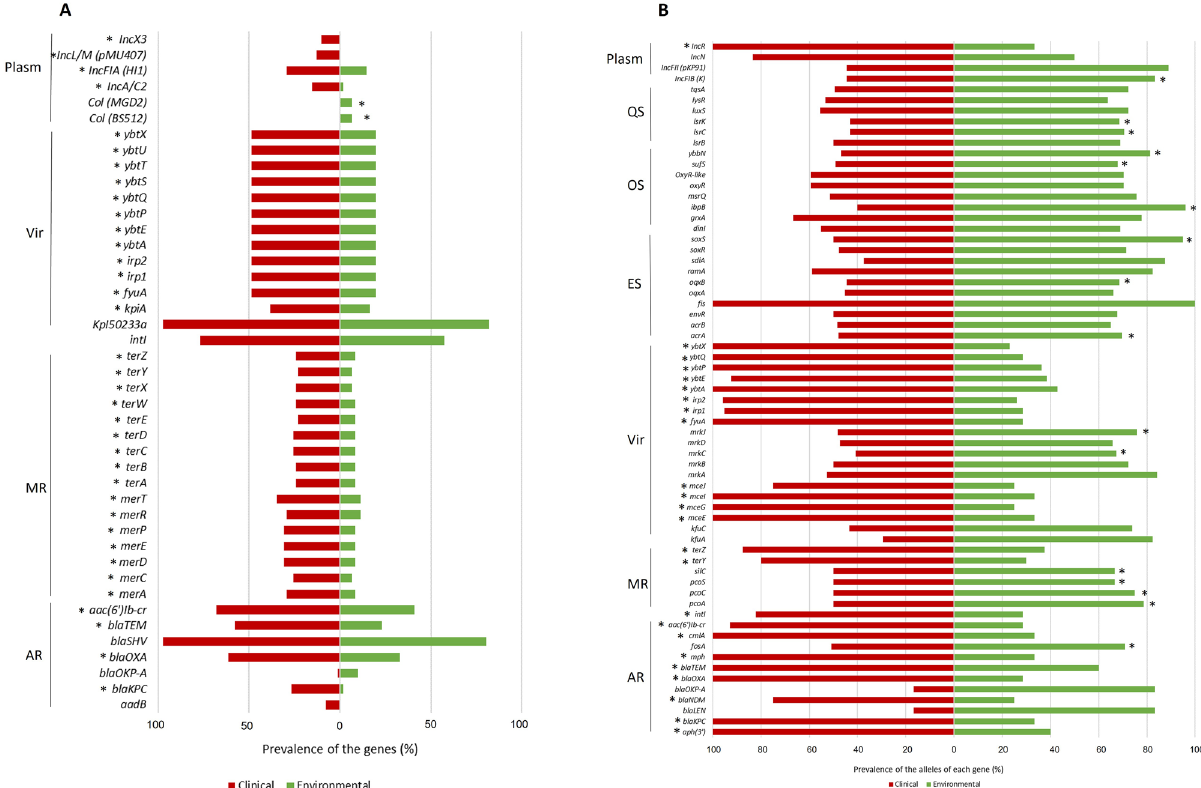
Figure 2. Statistically significant differences observed between clinical and environmental K. pneumoniae and closest related species genomes analysed. ( A ) Prevalence (%) of genes (Fisher’s exact test and p-value < 0.05); ( B ) The Shannon diversity index was determined for the alleles of each gene and the genes with significant differences between clinical and environmental genomes were identified (p-value < 0.05). The prevalence (%) of the alleles of these genes, meaning variants of a single gene that differ in at least one nucleotide, is presented. The prevalence of the genes or of the gene-alleles was determined based on the following formula: Prevalence (%) = 100 × (Number of clinical or environmental genomes containing the gene A/total number of clinical or environmental genomes) or 100 × (Number of observed variants of gene A in clinical or environmental genomes/total number of observations of the gene A in clinical or environmental genomes). *Indicates statistically significant differences between clinical and environmental within K. pneumoniae genomes. Some genes such as bla LEN and bla OKP-A were only observed in the K. variicola and K. quasipneumoniae species, respectively. AR antibiotic resistance, MR metal resistance, Vir virulence, Plasm plasmids, ES efflux systems,